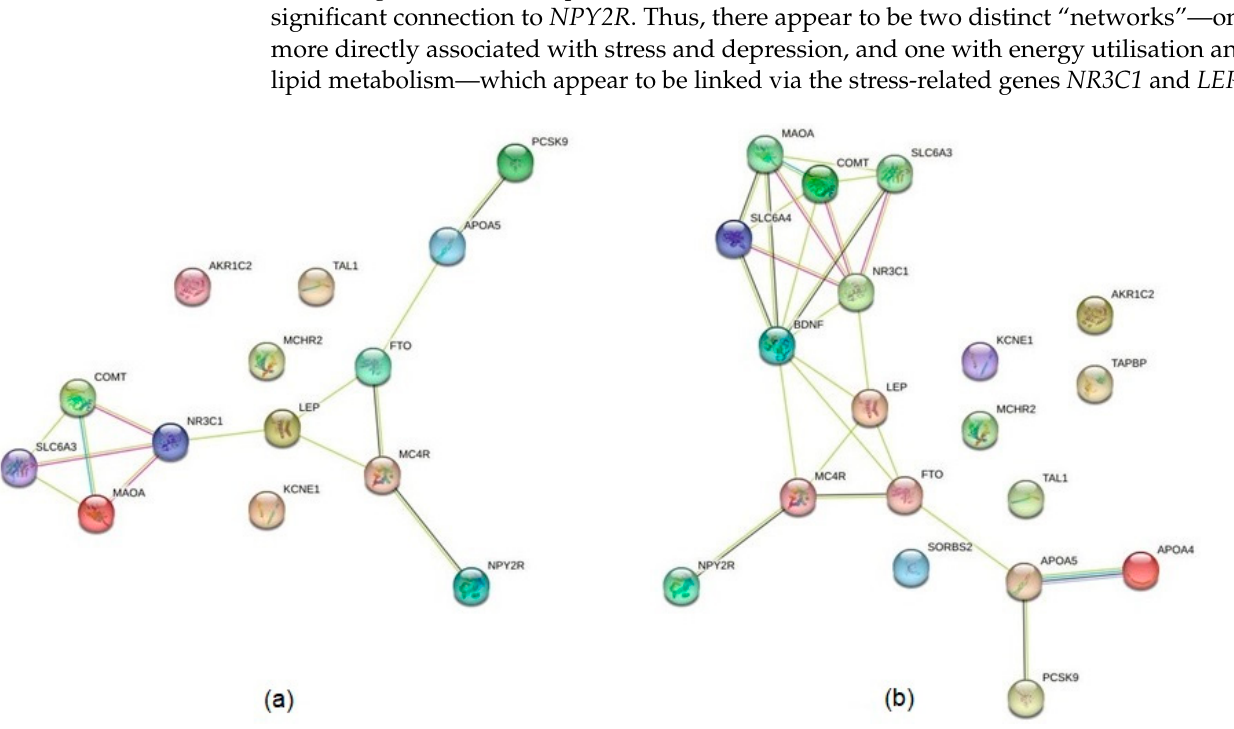
Figure 2. Maps of possible protein–protein interactions for the genes identified in the current review, based on the STRING database.